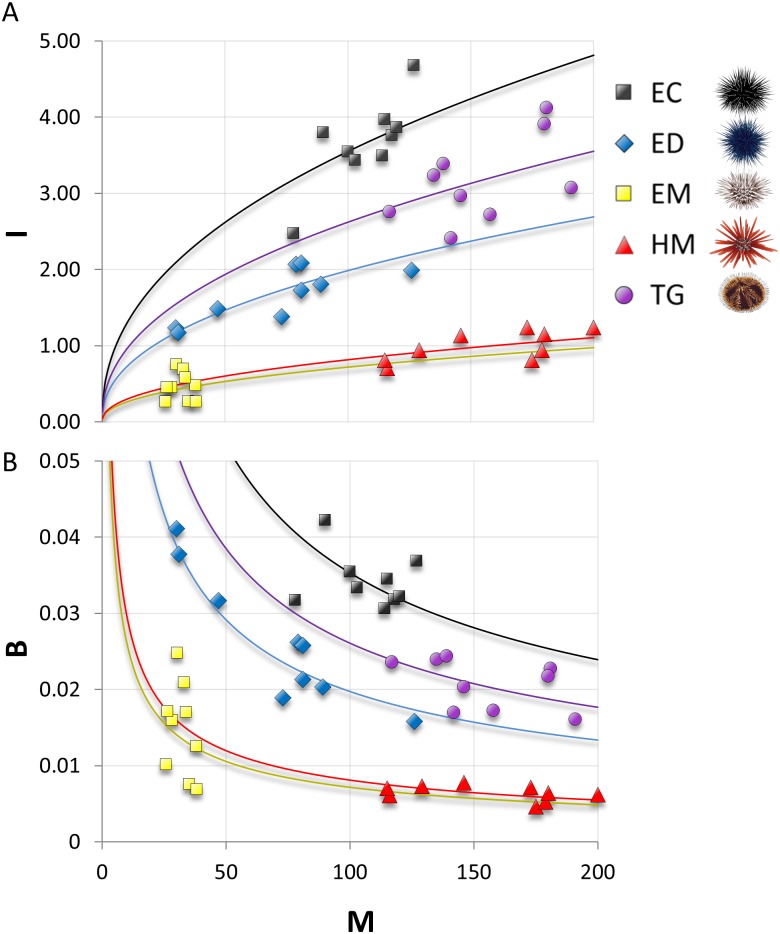
Back-transformed (raw) metabolic scaling relationships.Echinoid mass (M in g) versus (A) individual metabolic rate (I in mgO2/h), and (B) biomass-specific metabolic rate (B in mgO2/g/h). Lines represent corresponding scaling functions from Table 4. Urchin codes as in Fig 1a.